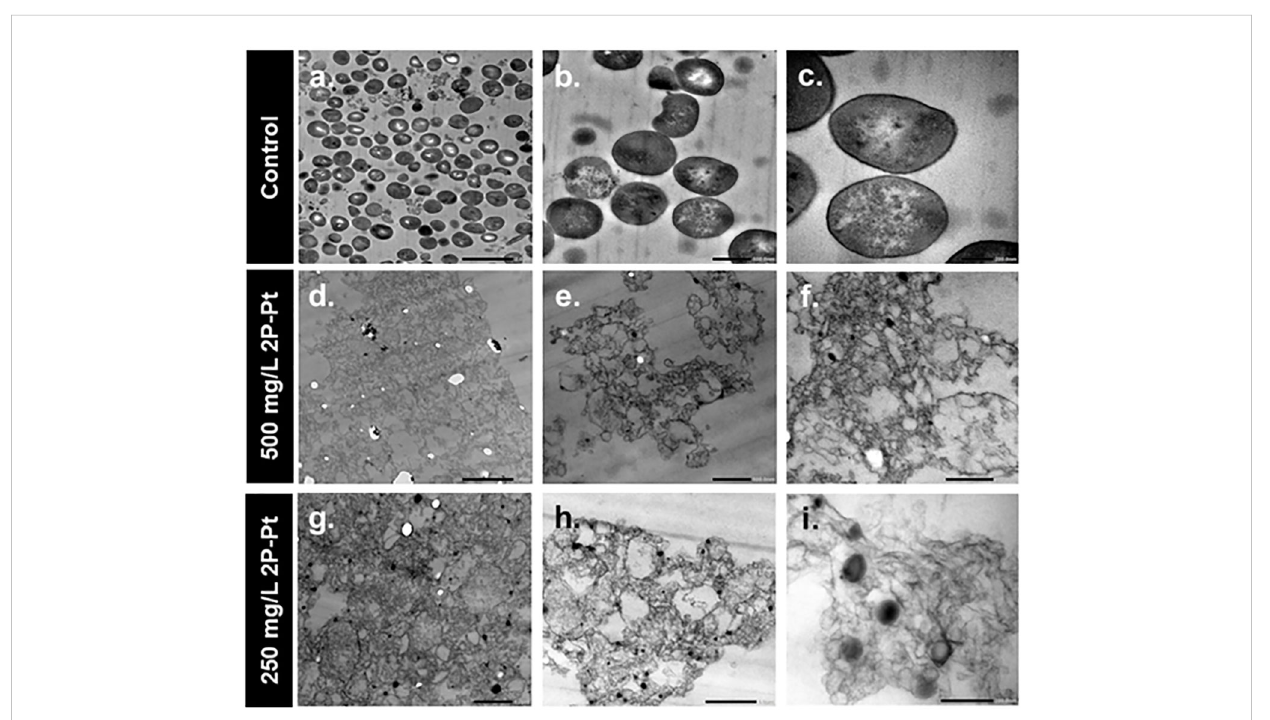
FIGURE 5 TEM images of planktonic cells of S. aureus ATCC 25923 versus control (A – C) and treated with the 2P-Pt complex at concentrations of 500mg/L (D – F) and 250 mg/L (G – I)